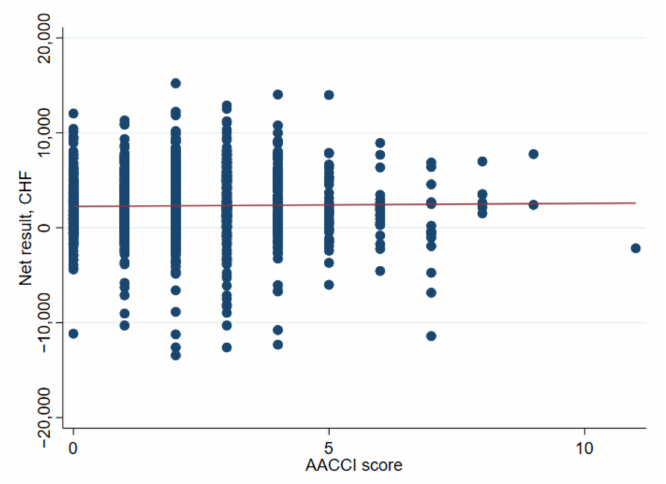
Figure 8. AACCI and net financial results-no statical relevant correlation.